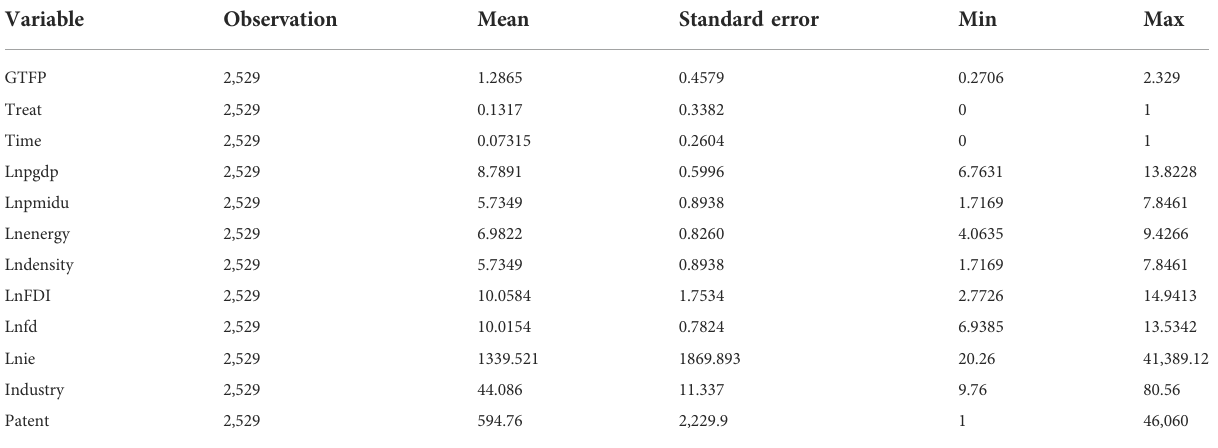
TABLE 1 Main variable description